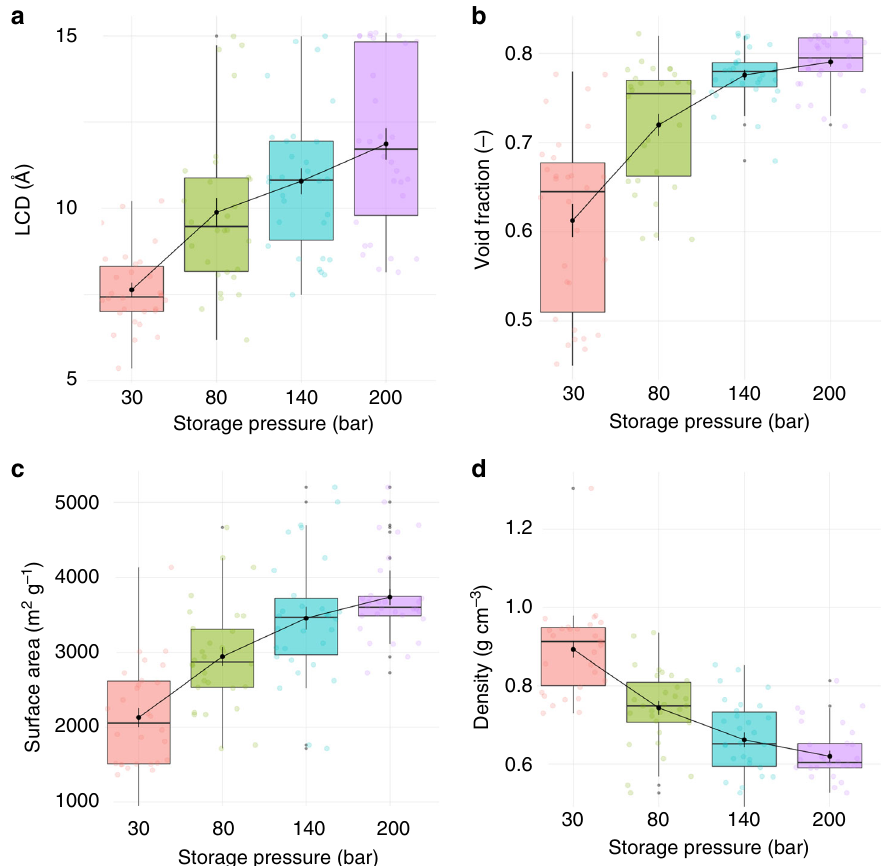
Fig. 5 Optimal geometric properties for the top 1% of MOF structures. Box and whisker plots representing a largest cavity diameter (LCD), b void fraction, c surface area and d density, for storage pressures of 30, 80, 140 and 200 bar. The markers represent the minimum, fi rst quartile, median, third quartile, and maximum values, respectively. Outliers, identi fi ed as 1.5 × the minimum or maximum values, are represented by gray data points. Mean values for different pressures are connected via lines with bars representing standard deviation. Data points are offset laterally for better